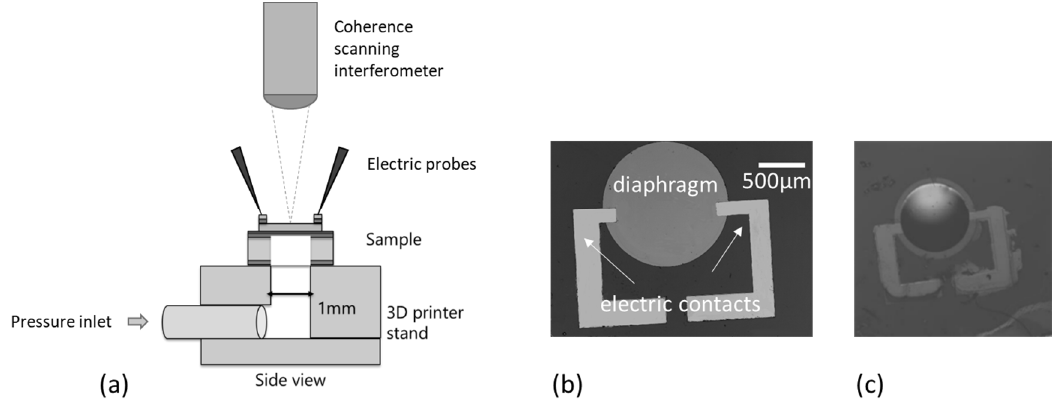
Figure 3. ( a ) Schematic setup to characterize the pressure sensor. ( b ) Microscopic image of a diaphragm and its contacts. ( c ) Picture of a device with deformed diaphragm during measurement.